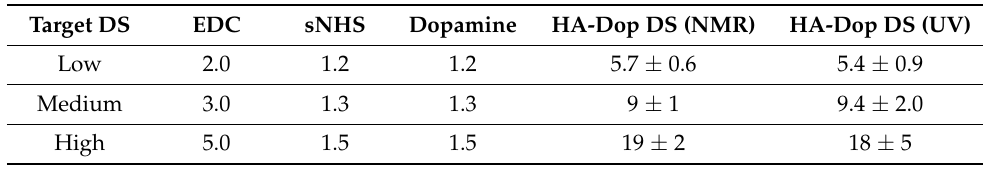
Table 1. Molar equivalents of the reactants relative to HA carboxyl and mean DS obtained over n = 3 batches of HA-Dop synthesis ( n = 3).